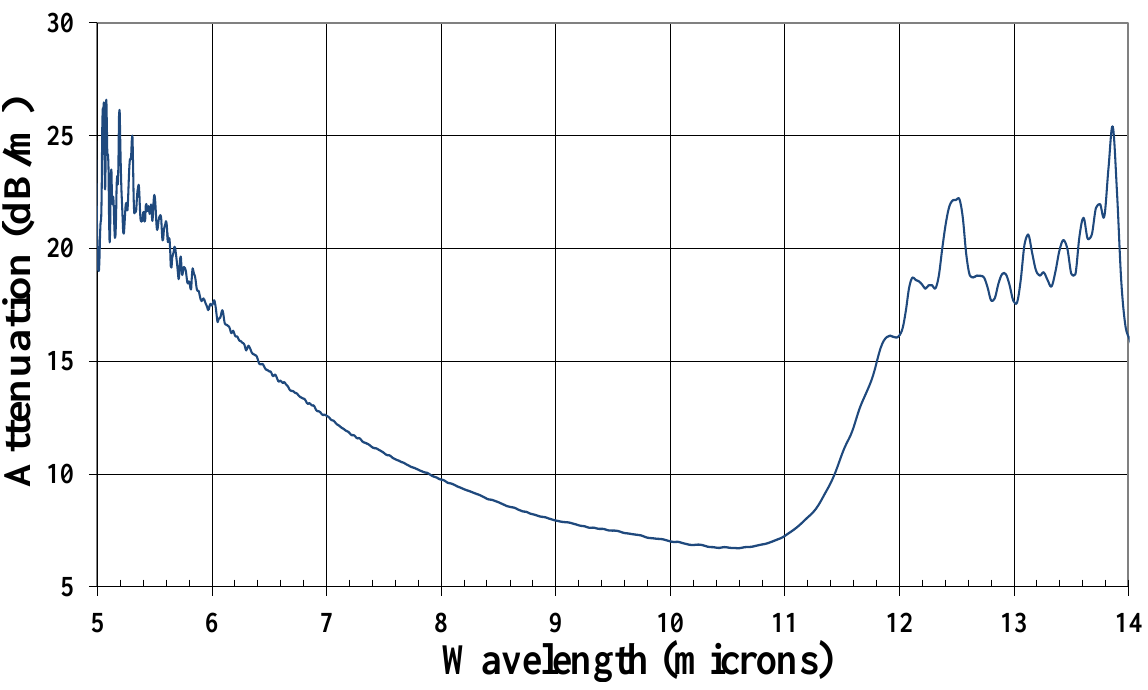
Te Se glass fiber showing minimum loss around 21 76 3